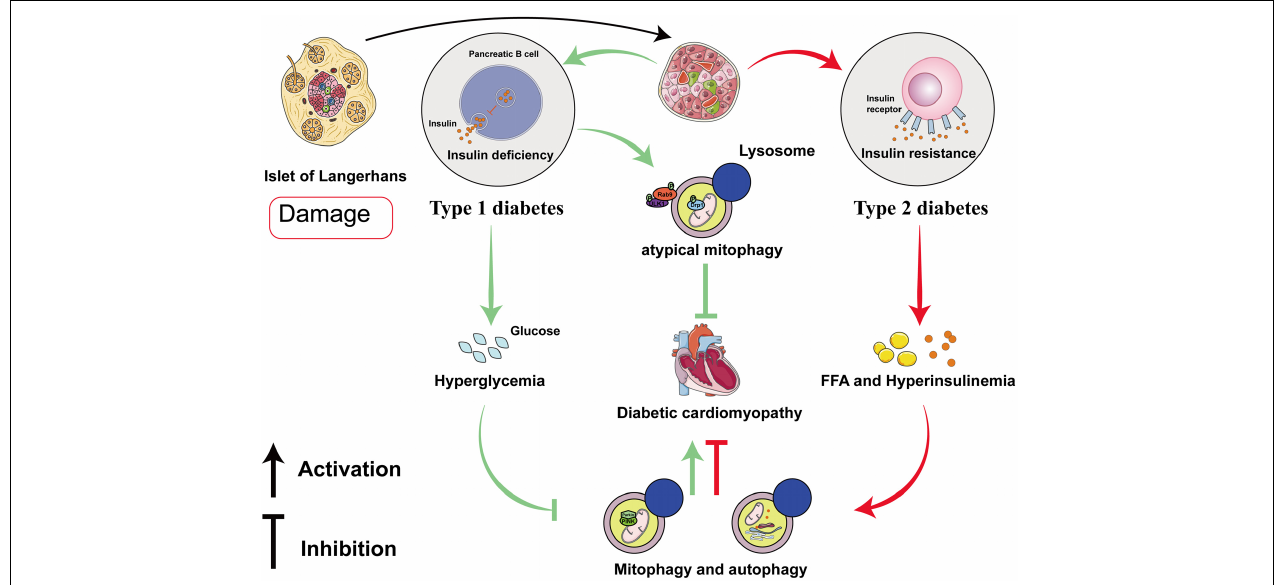
FIGURE 2 | Roles of mitophagy and autophagy in diabetic cardiomyopathy in type 1 and type 2 diabetes mellitus. In diabetic cardiomyopathy (DCM) in T1DM, autophagy and PINK/parkin-mediated mitophagy are impaired, but atypical mitophagy is activated to limit cardiac damage. In DCM in T2DM, both autophagy and mitophagy are activated in the early stages, and they play compensatory roles that protect the